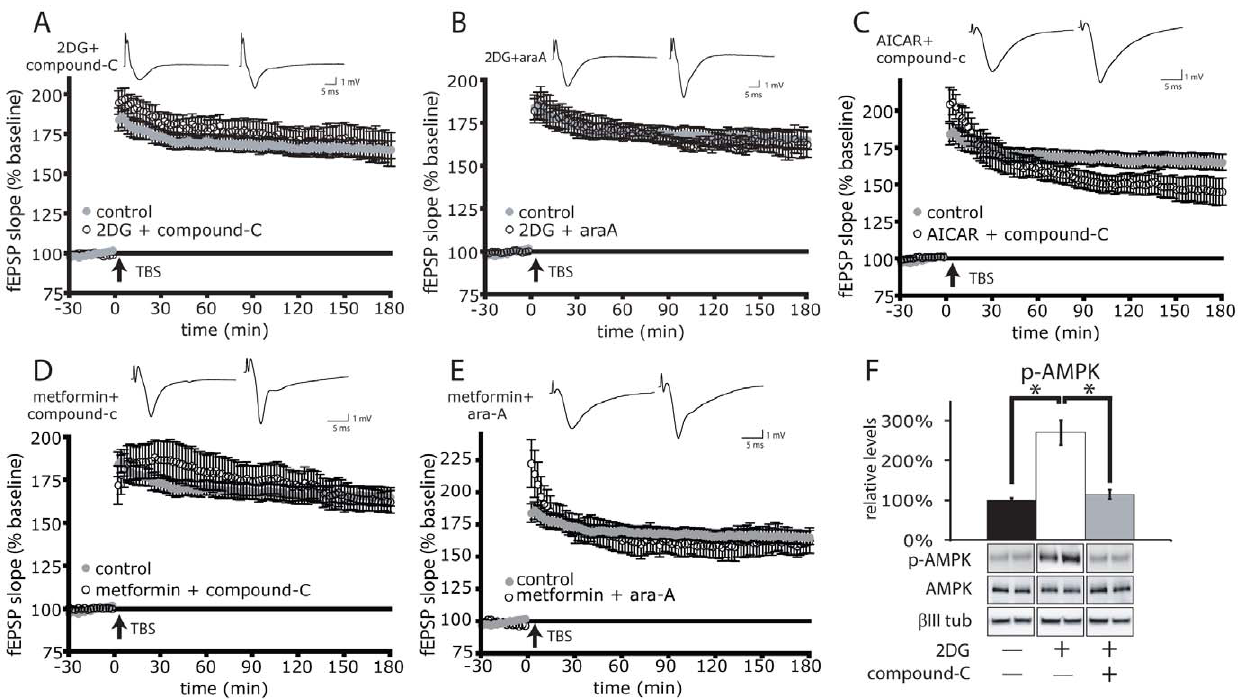
Figure 4. AMPK inhibition rescues L-LTP expression. AMPK inhibitors prevent TBS-induced L-LTP loss in the presence of 2DG, metformin or AICAR. A) 1 m M compound-C (n=9) or B) 100 m M araA (n=6) prevent 10 mM 2DG-mediated loss of L-LTP. C) 1 m M compound-C prevents 1 mM AICAR-mediated loss of L-LTP (n=6). D) 1 m M compound-C (n=9) or E) 100 m M araA (n=6) prevents 5 m M metformin-mediated loss of L-LTP. Control data from Fig. 3B is reproduced in Fig. 4A and Fig. 4B for comparison. A–E) Inset: representative fEPSP traces shown were taken 4 minutes prior and 180 minutes after stimulation. F) 1 m M compound-C abolishes 10 mM 2DG-mediated AMPK activation. Slices were incubated in ACSF (n=8), 10 mM 2DG (n=5) or both 10 mM 2DG and 1 m M compound-C (n=6) for 30 minutes, subjected to western blotting and quantified as in Fig. 1A. *p=0.0002. Error bars show s.e.m.